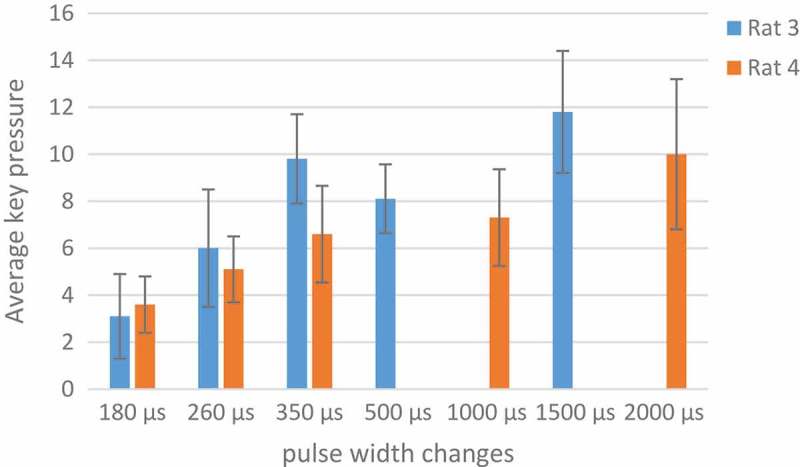
An analysis of optimum pulse width.